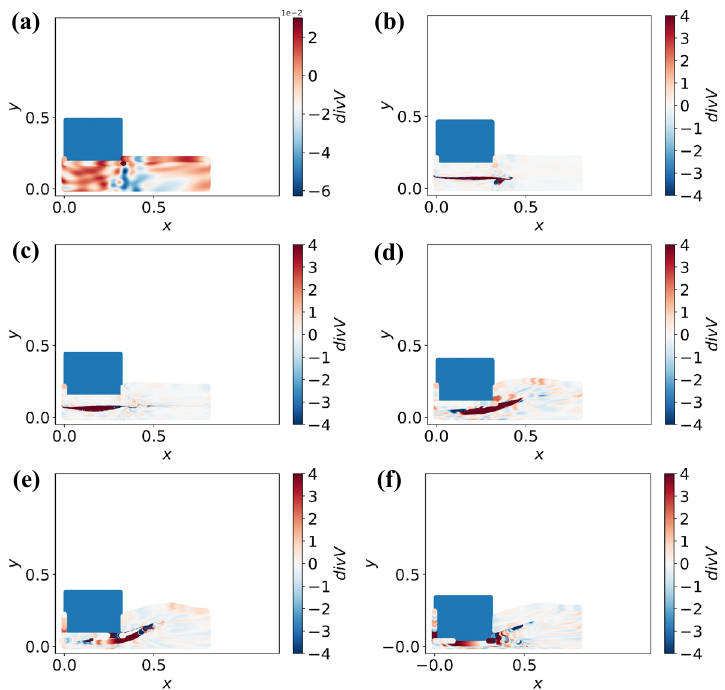
Fig. 6 The surge morphology and divergence distribution diagram. Water depth D = 0 . 21 m. Each map corresponds to a different moment. a 2 dt. b 3 dt. c 4 dt. d 6 dt. e 7 dt. f 9